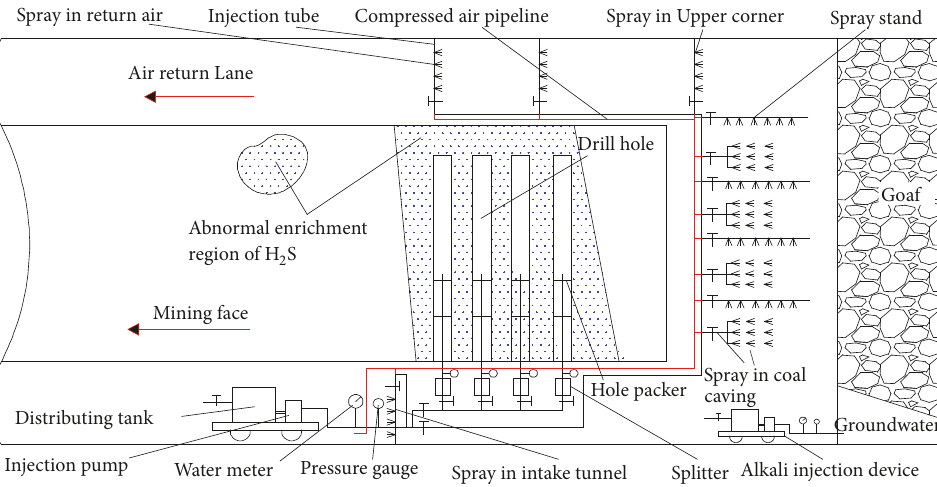
Figure 18: Scheme of comprehensive prevention and control technology of H 2 S on a longwall face in coal